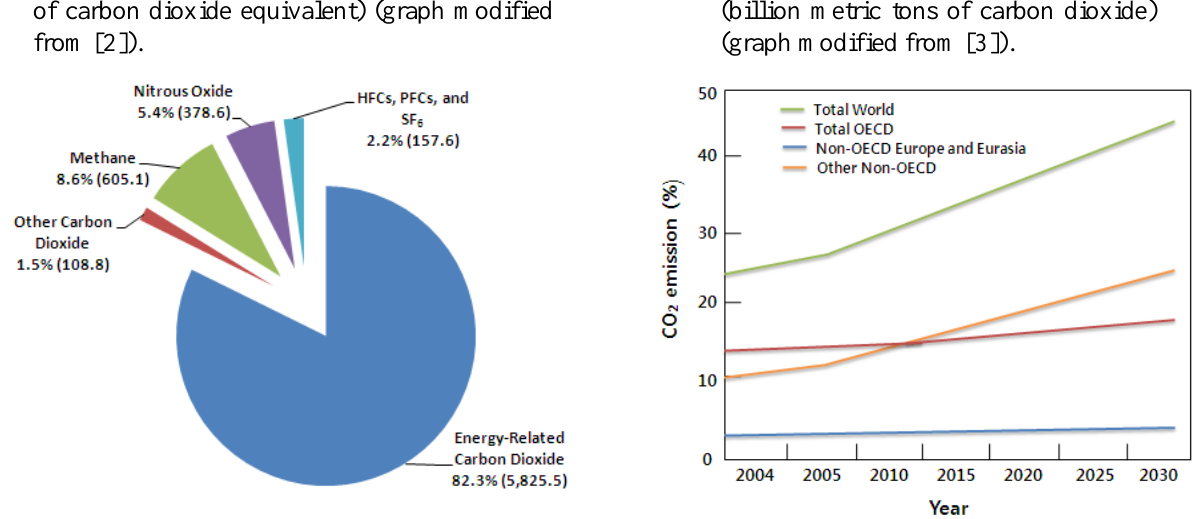
Figure 1. U.S. anthropogenic greenhouse gas emissions by gas in 2006 (million metric tons of carbon dioxide equivalent) (graph modified from [2]).